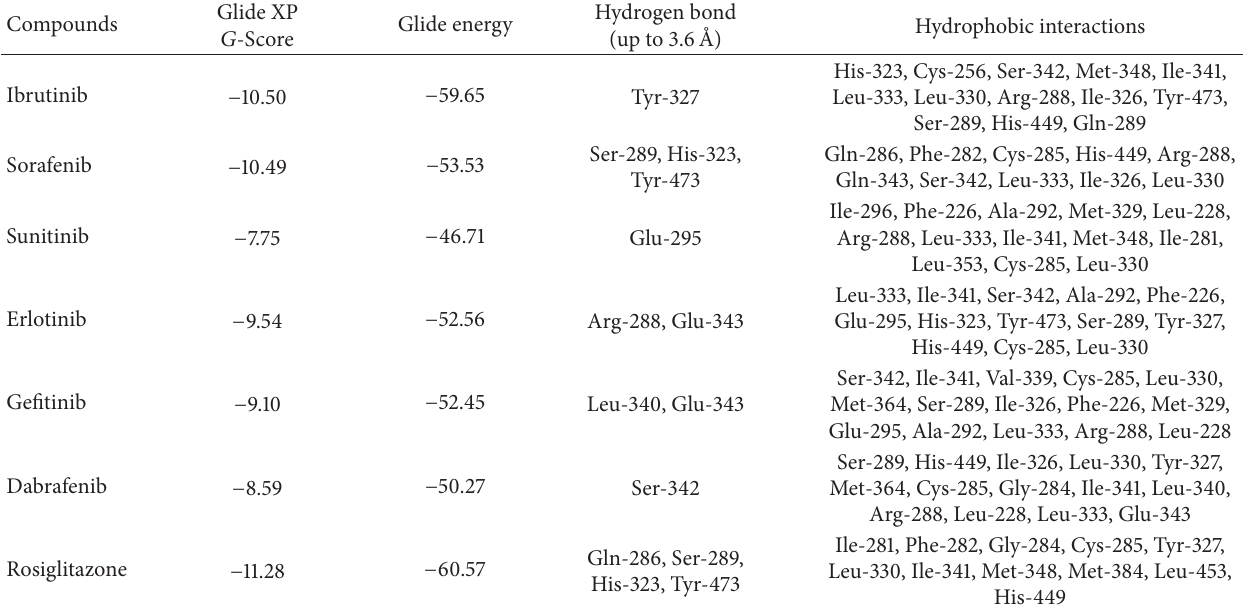
Table 1: Glide docking scores (kcal mol −1 ), docking energies, and calculated hydrogen bond and hydrophobic interactions of TKIs and reference compound rosiglitazone bound to human PPAR gamma binding